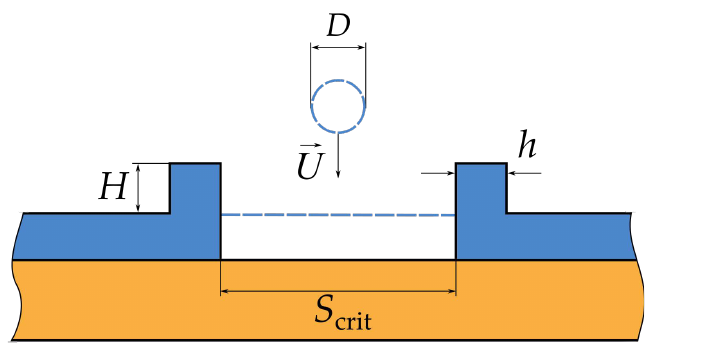
Figure 4. Model of the crater formation. The blue dashed lines show a droplet and film before